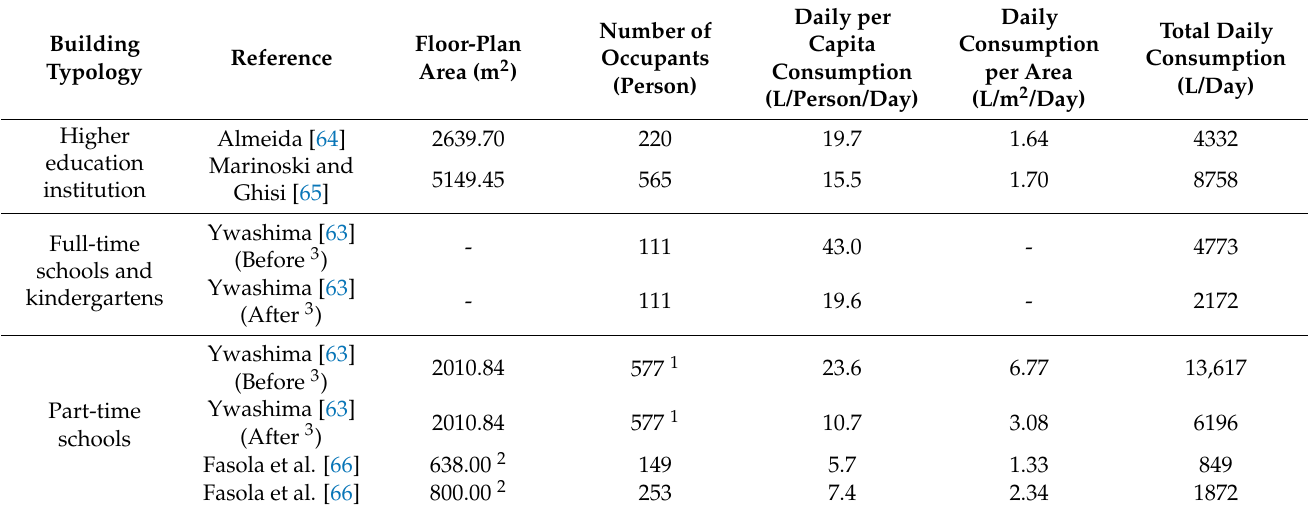
Table 1. Water consumption profiles in educational institutions in